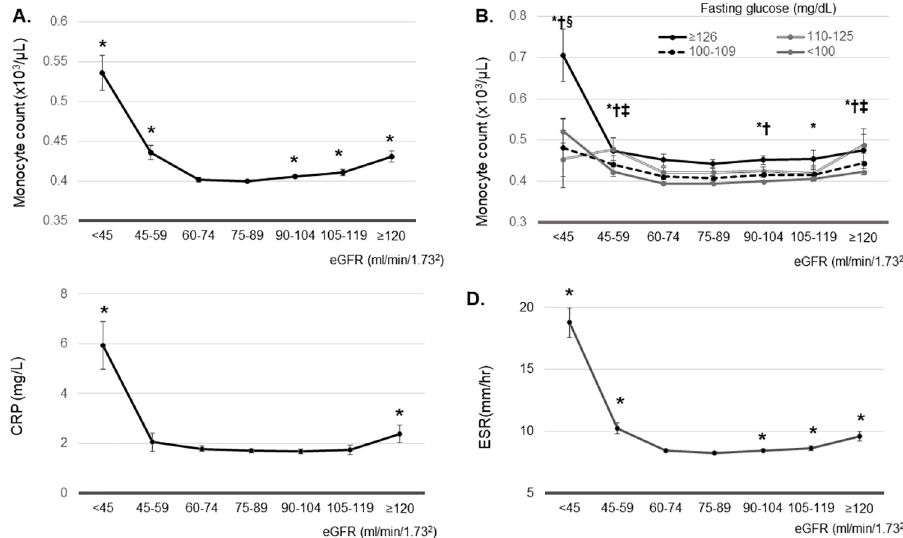
Fig 2. (A) Estimated mean of monocyte count according to estimated glomerular filtration rate (eGFR). � P < 0.05, vs. eGFR 75–89 ml/min/1.73m 2 . (B) Estimated mean of monocyte count according to estimated glomerular filtration rate according to the fasting blood sugar (FBS). � P < 0.05, vs. eGFR 75–89 ml/min/1.73m 2 in participants with FBS < 100 mg/dL. † P < 0.05, vs. eGFR 75–89 ml/min/1.73m 2 in participants with FBS 100–109 mg/dL. ‡ P < 0.05, vs. eGFR 75–89 ml/min/1.73m 2 in participants with FBS 110–125 mg/dL. § P < 0.05, vs. eGFR 75–89 ml/min/1.73m 2 in participants with FBS � 126mg/dL. (C) Estimated mean of C-reactive protein according to estimated glomerular filtration rate. � P < 0.05, vs. eGFR 90–105 ml/min/1.73m 2 . (D) Estimated mean of erythrocyte sedimentation rate according to estimated glomerular filtration rate. � P < 0.05, vs. eGFR 75–89 ml/min/1.73m 2 . Estimated means were adjusted by age, body mass index, systolic blood pressure, AST, ALT, bilirubin, fasting blood glucose, hemoglobin, triglyceride, LDL cholesterol, HDL cholesterol, and total cholesterol. in patients with eGFR 75–89 ml/min/1.73m 2 (Fig 2A). This reverse J-shape association was independent of fasting blood glucose level. Adjusted mean monocyte count was higher in par- ticipants with eGFR < 60 ml/min/1.73m 2 compared to that in patients with eGFR of 75–89 ml/ icantly higher in participants with eGFR � 120 ml/min/1.73m 2 compared to that in patients with eGFR of 75–89 ml/min/1.73m 2 with FBS < 110–125, 100–109, and < 100 mg/dL (Fig 2B).